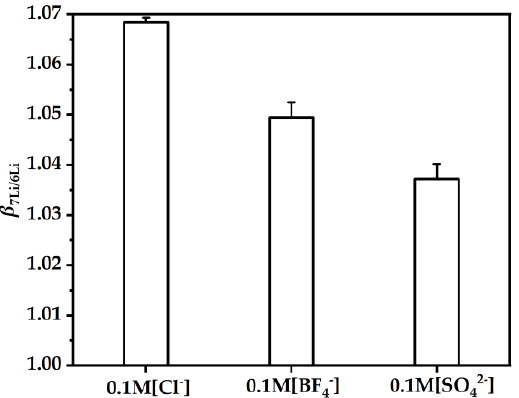
Figure 8. The DES extractant (molar ratio: HTTA/TOPO = 2/1) was used. The initial concentrations of Cl − , BF 4 − and SO 42 − were 0.1 M. The initial concentration of Li + was 25 ppm. Aqueous phase: organic phase = 4:1.